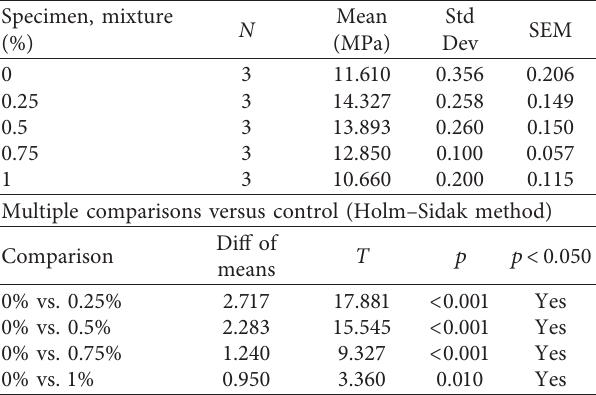
Figure 4: Compressive strength of specimens. Table 3: Descriptive and One-Way RM ANOVA of compressive